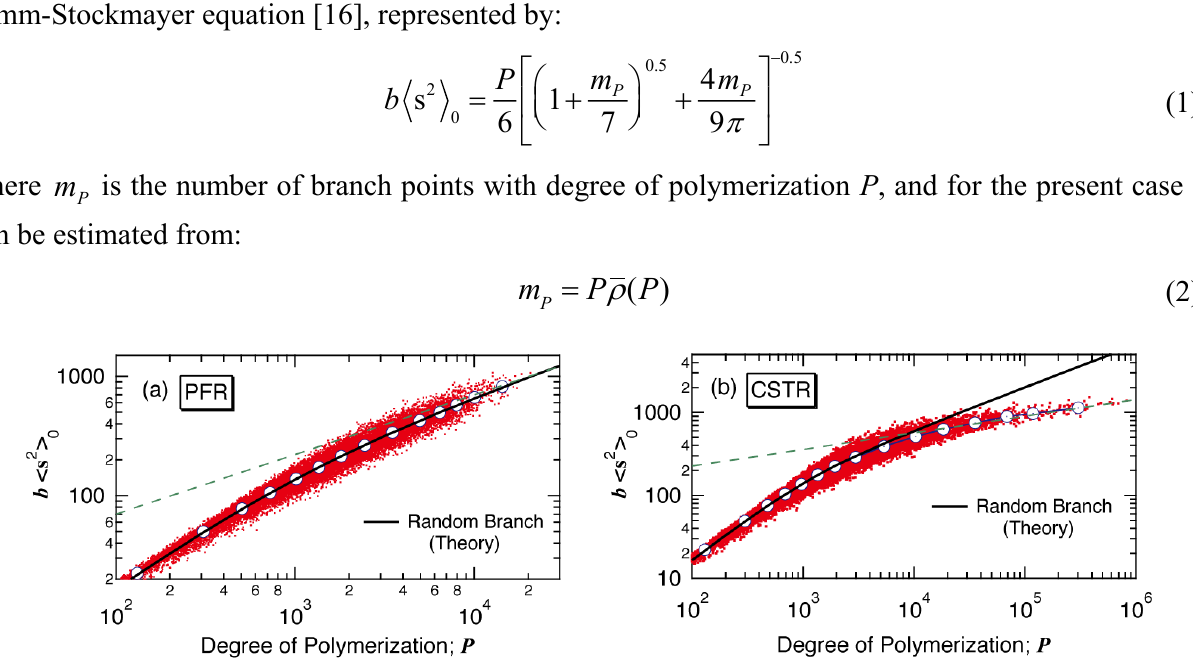
Figure 4. Relationship between the mean-square radius of gyration <s 2 > 0 and degree of polymerization P for the branched polymers formed in ( a ) a PFR and in ( b ) a CSTR